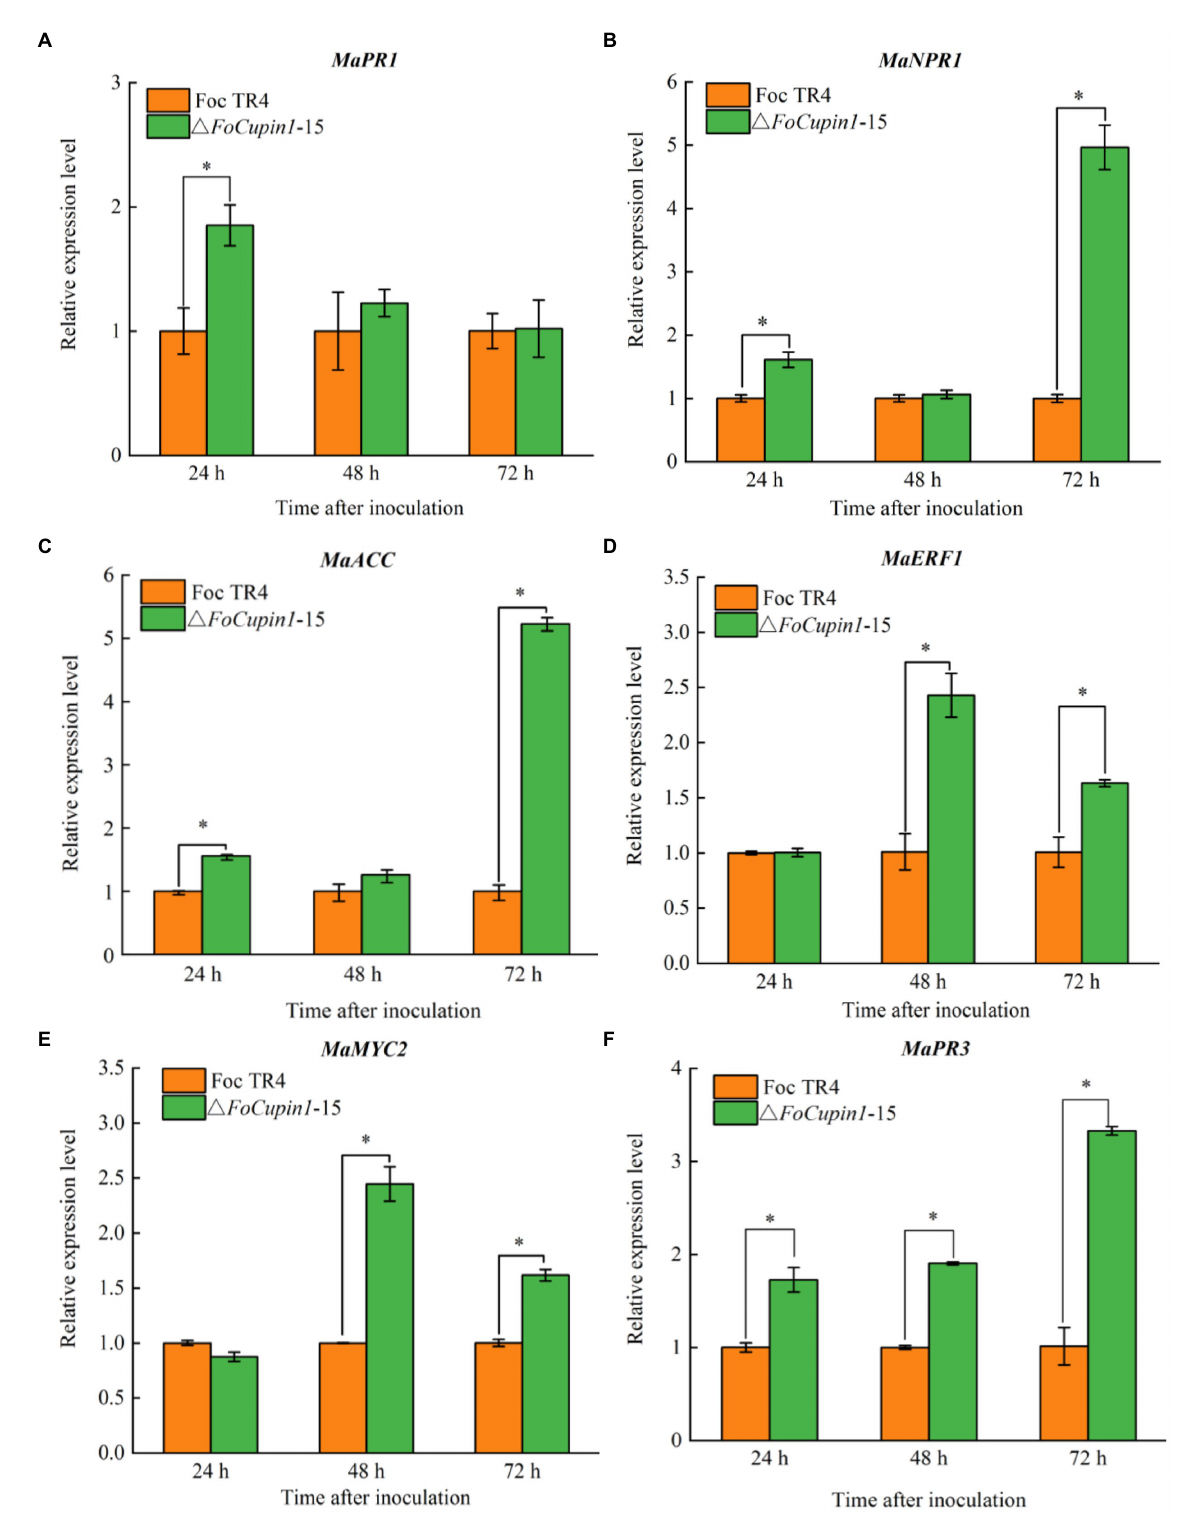
FIGURE 6 FoCupin1 suppresses the expression of six defense-related genes in banana by RT-qPCR. (A) MaPR1 . (B) MaNPR1 . (C) MaACC . (D) MaERF1 . (E) MaMYC2 . (F) MaPR3 . Expression levels of these genes were induced stronger during the early stage in △ FoCupin1 -treated banana than wild type-treated bananas. Values are the means (±SE) based on three independent experiments and bars indicate standard deviations. Asterisks indicate statistical significance ( p < 0.5) using Student’s t